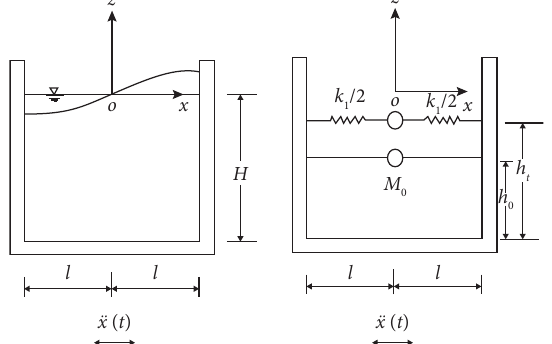
Figure 1: Hydrodynamic pressure calculation model of the